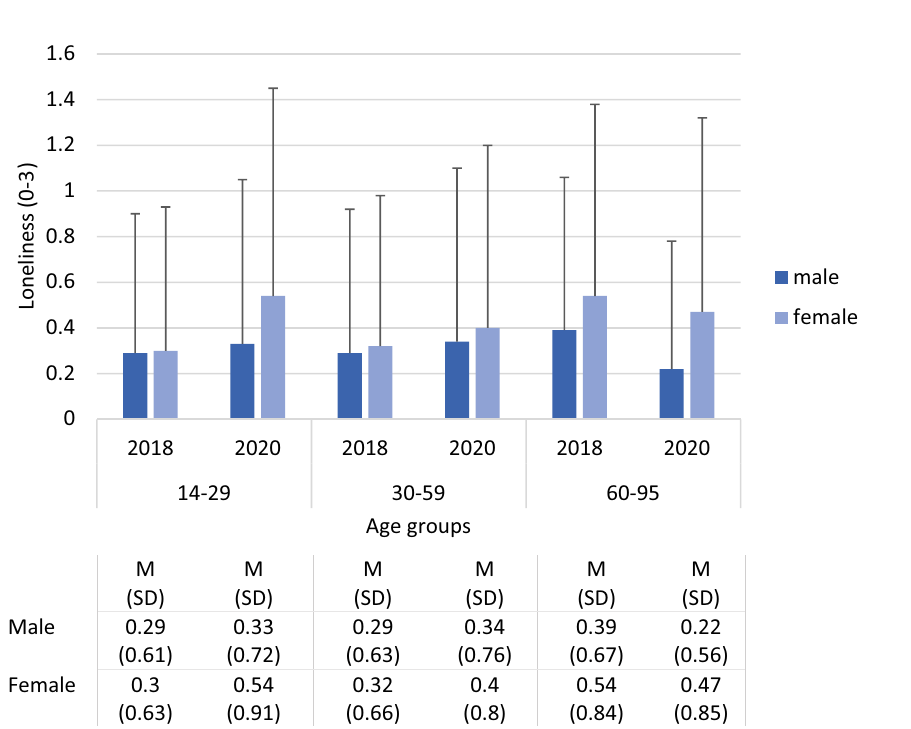
Figure 3. Loneliness scores in 2018 and 2020 by age group and sex. Analysis of variance: Survey (2018, 2020) by sex (male, female) by age group (14–29, 30–59, 60–95); F survey (df = 1) = 3.16, p = .076; F Sex (df = 1) = 22.75, p < .001; F age group (df = 2) = 4.99, p = .007; F survey by sex (df = 1) = 4.16, p = .041; F survey by age group (df = 2) = 10.64, p < .001; F sex by age group (df = 2) = 5.14, p =